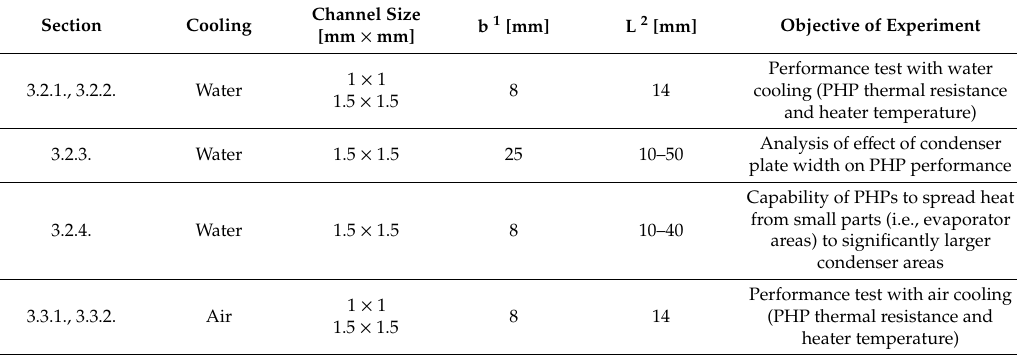
Table 1. Overview of experiments and